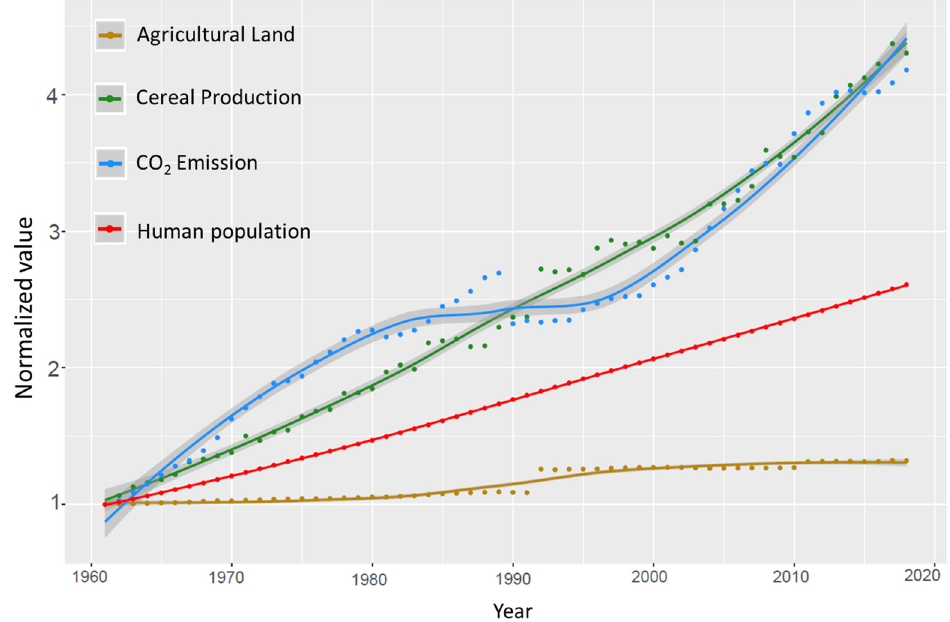
Figure 5. Global agricultural land use, cereal production, carbon dioxide (CO 2 ) emissions, and population data over the period 1961–2018 normalized to a value of unity in 1961, showing the positive relationship between cereal production and population growth with CO 2 emissions. Produced using freely available data from the World Bank data bank [36].